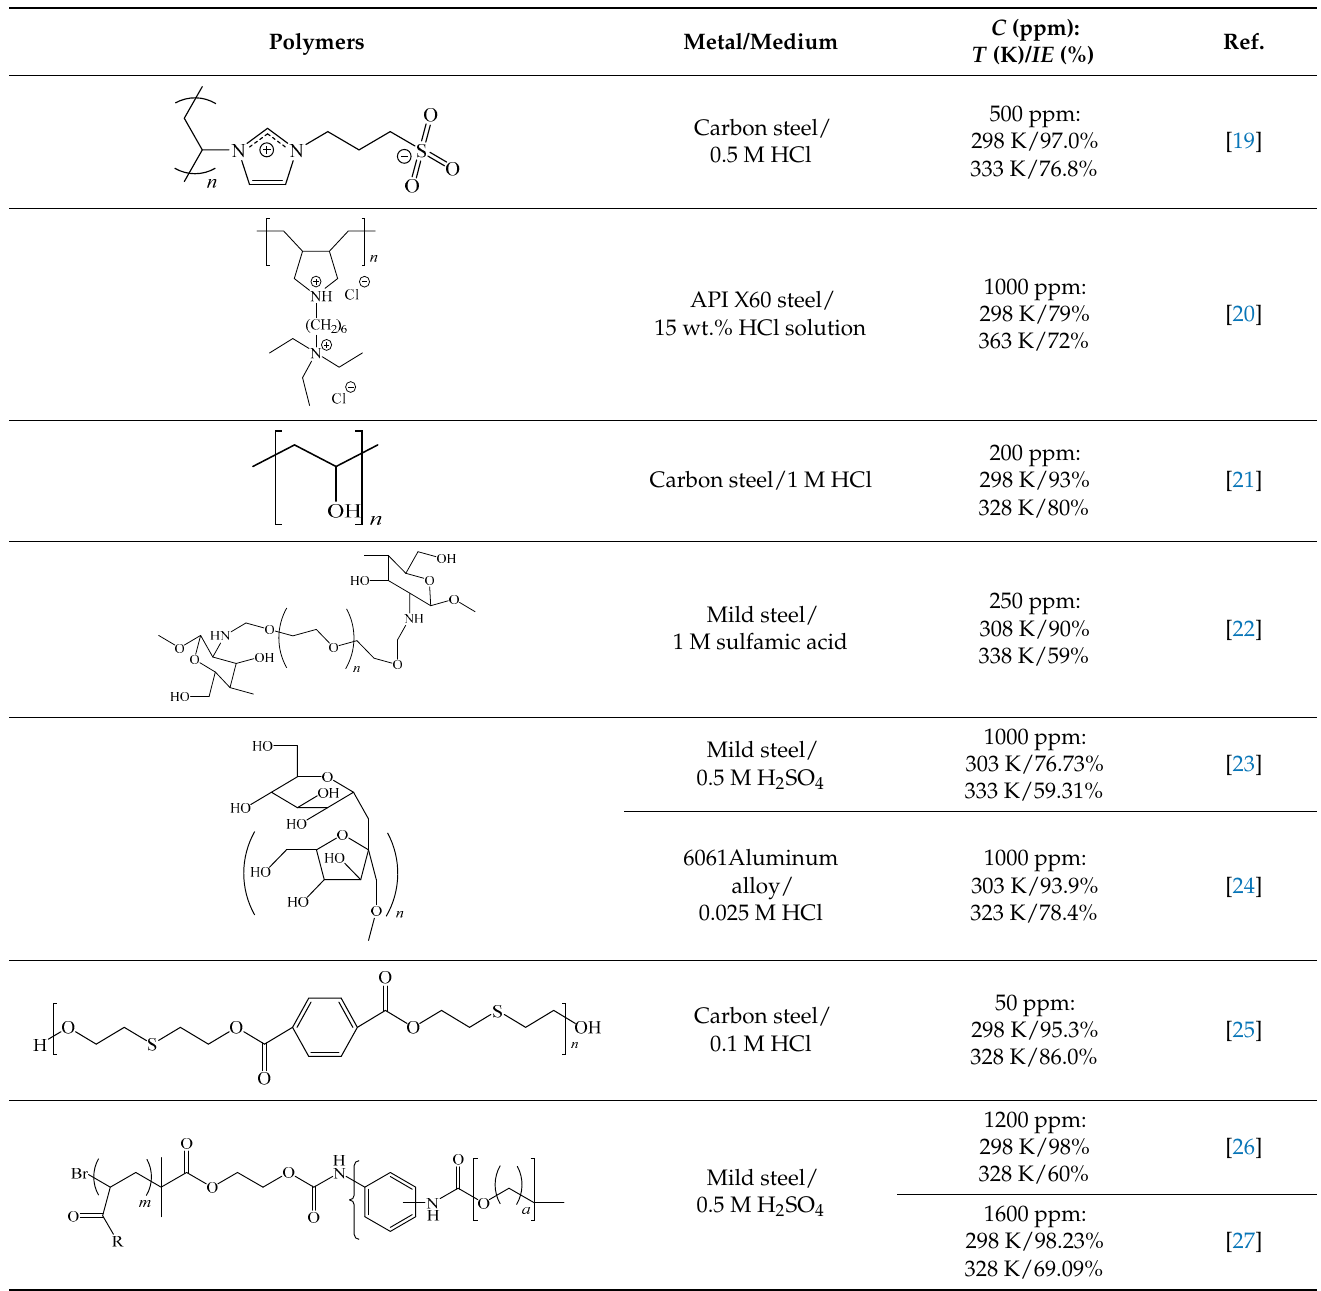
Table 1. State of the art of polymers and PILs. Polymers